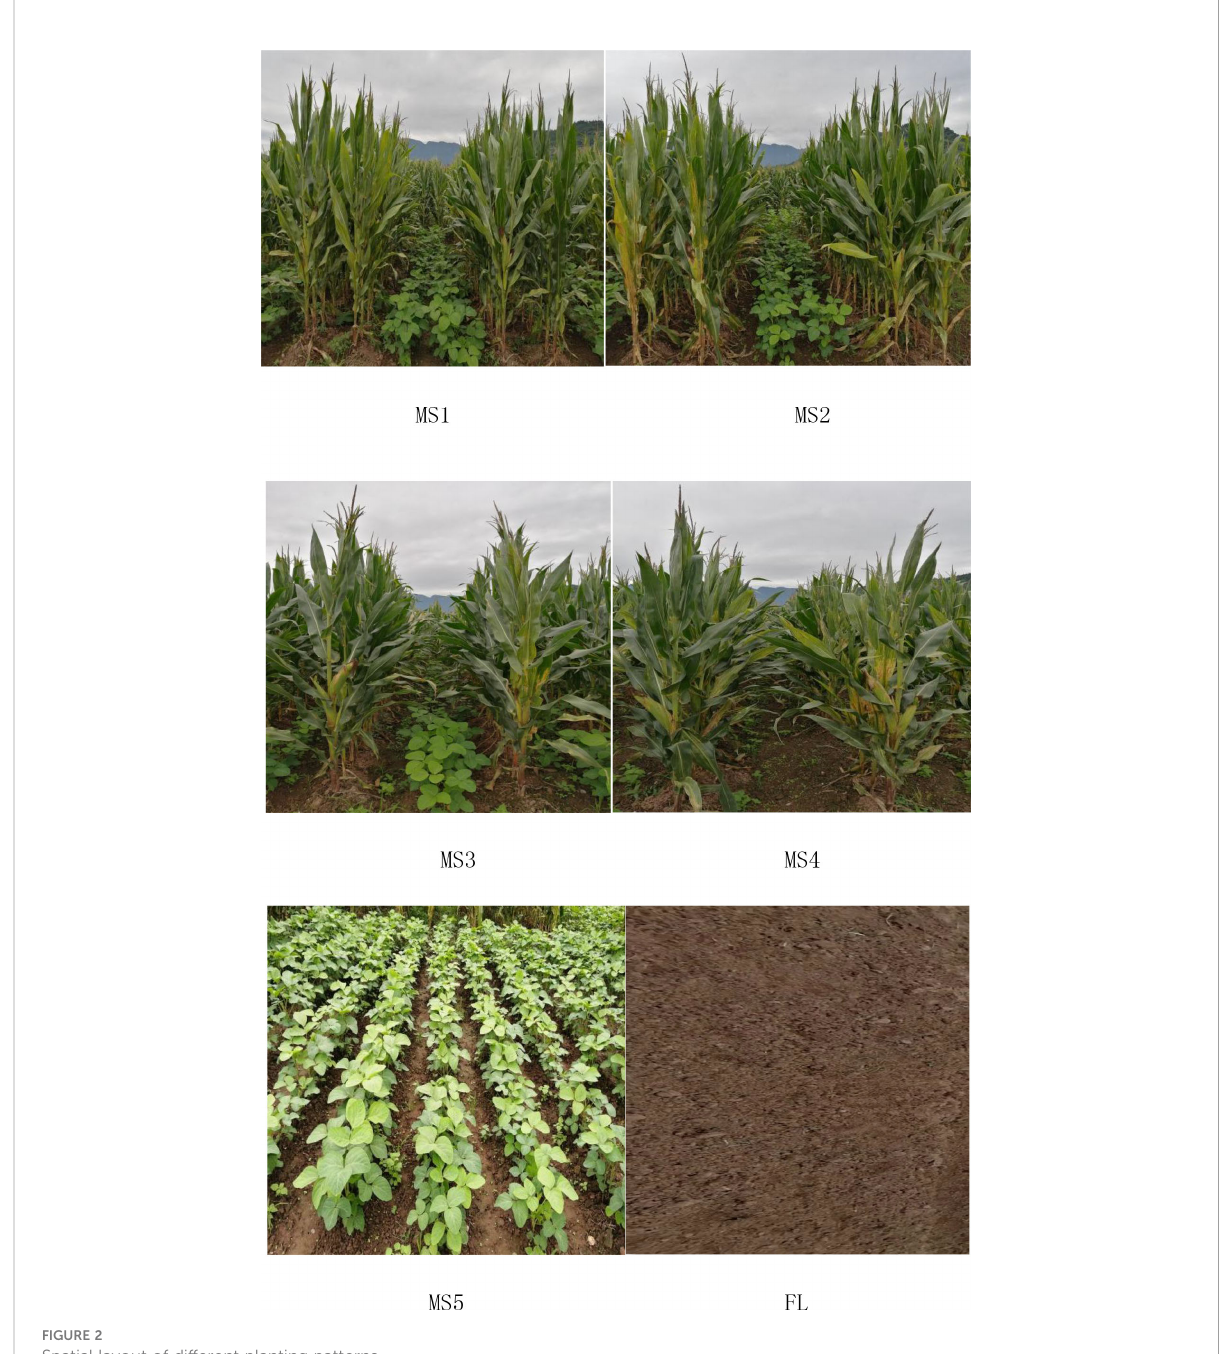
FIGURE 2 Spatial layout of different planting